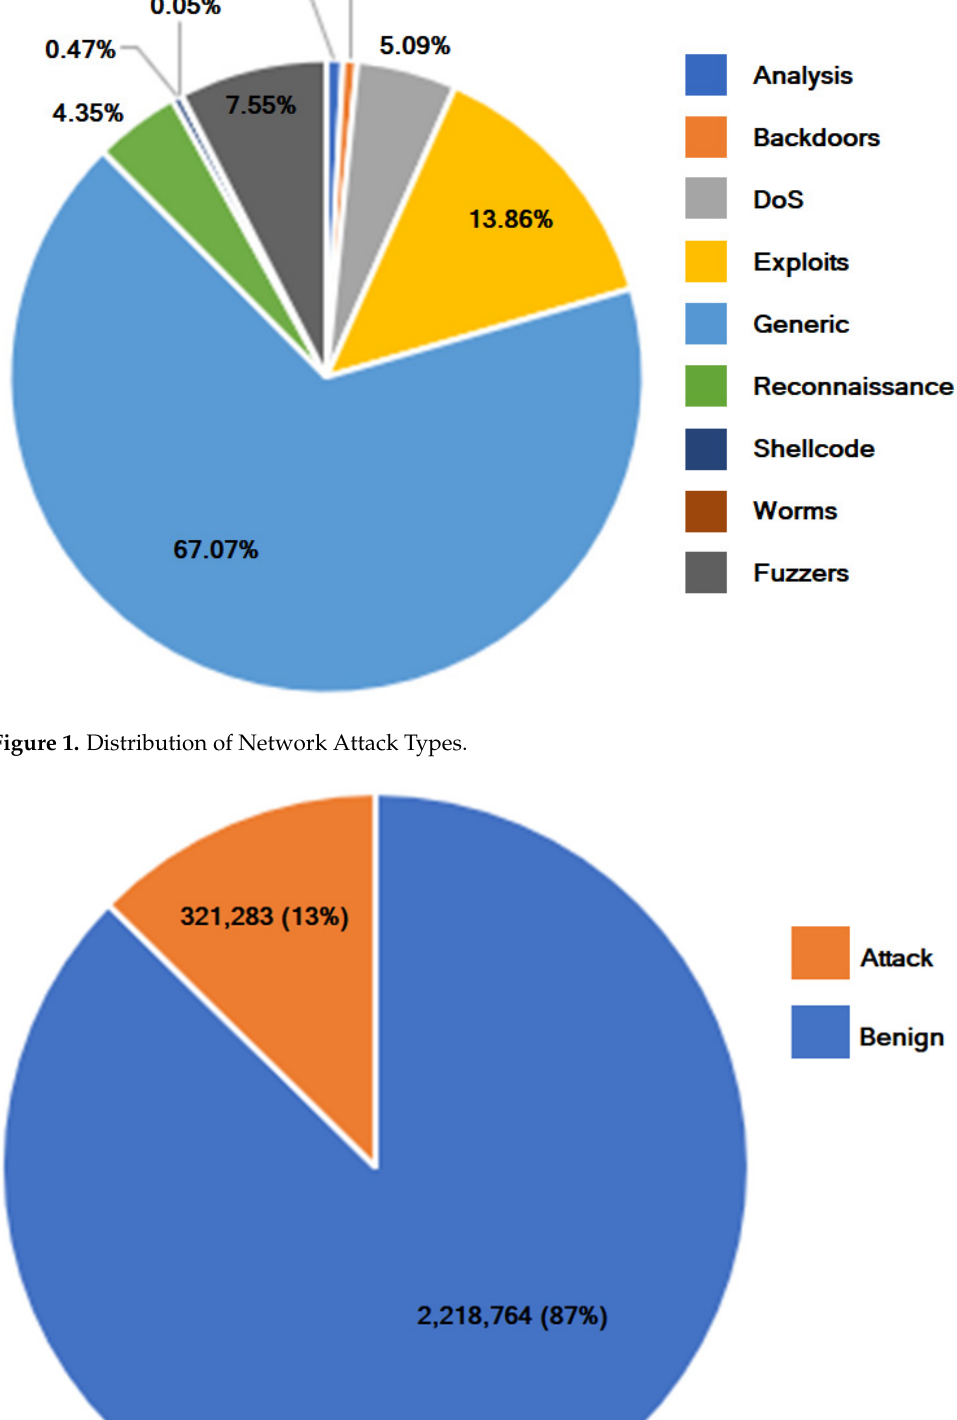
Figure 2. Distribution of Benign versus Attacks.